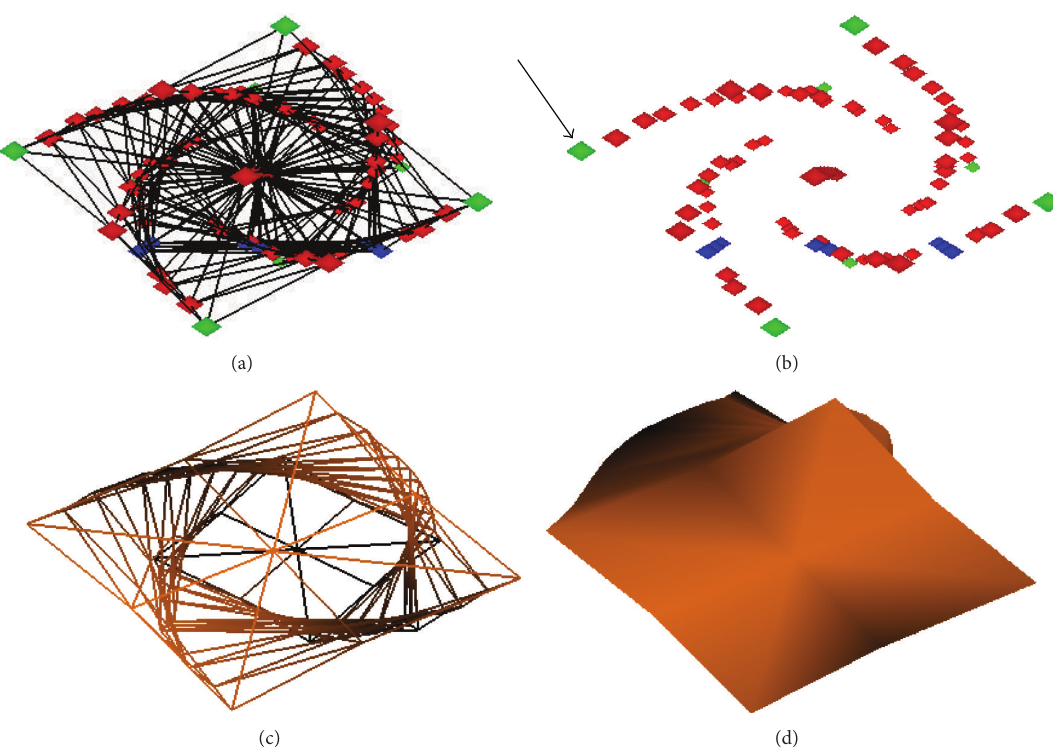
Figure 7: Nonlinear FEM results for the both the proposed and Pedersen’s methods ((a) wireframe tetrahedra and nodes; (b) nodes only; (c) wireframe surface mesh; and (d) shaded mesh).